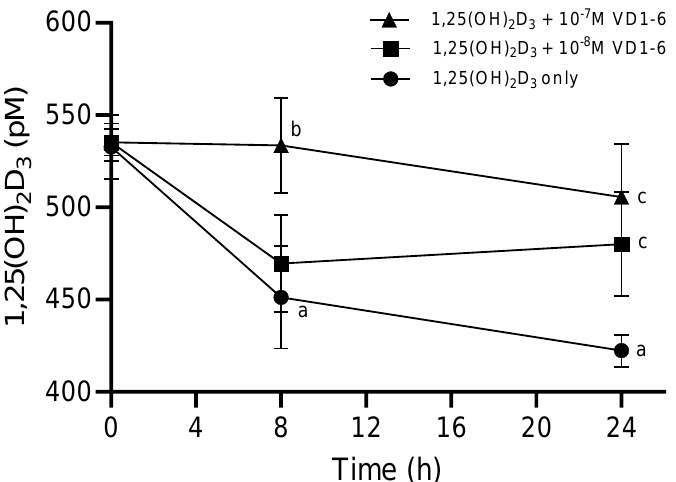
Figure 4. Levels of 1,25(OH) 2 D 3 in HEK293T cell culture at 0, 8, and 24 h in the absence and presence of VD1-6 at 10 −8 M and 10 −7 M. Mean ± S.D, n = 4/group; a p < 0.05 vs 0 h; b p < 0.05 vs. 1,25(OH) 2 D 3